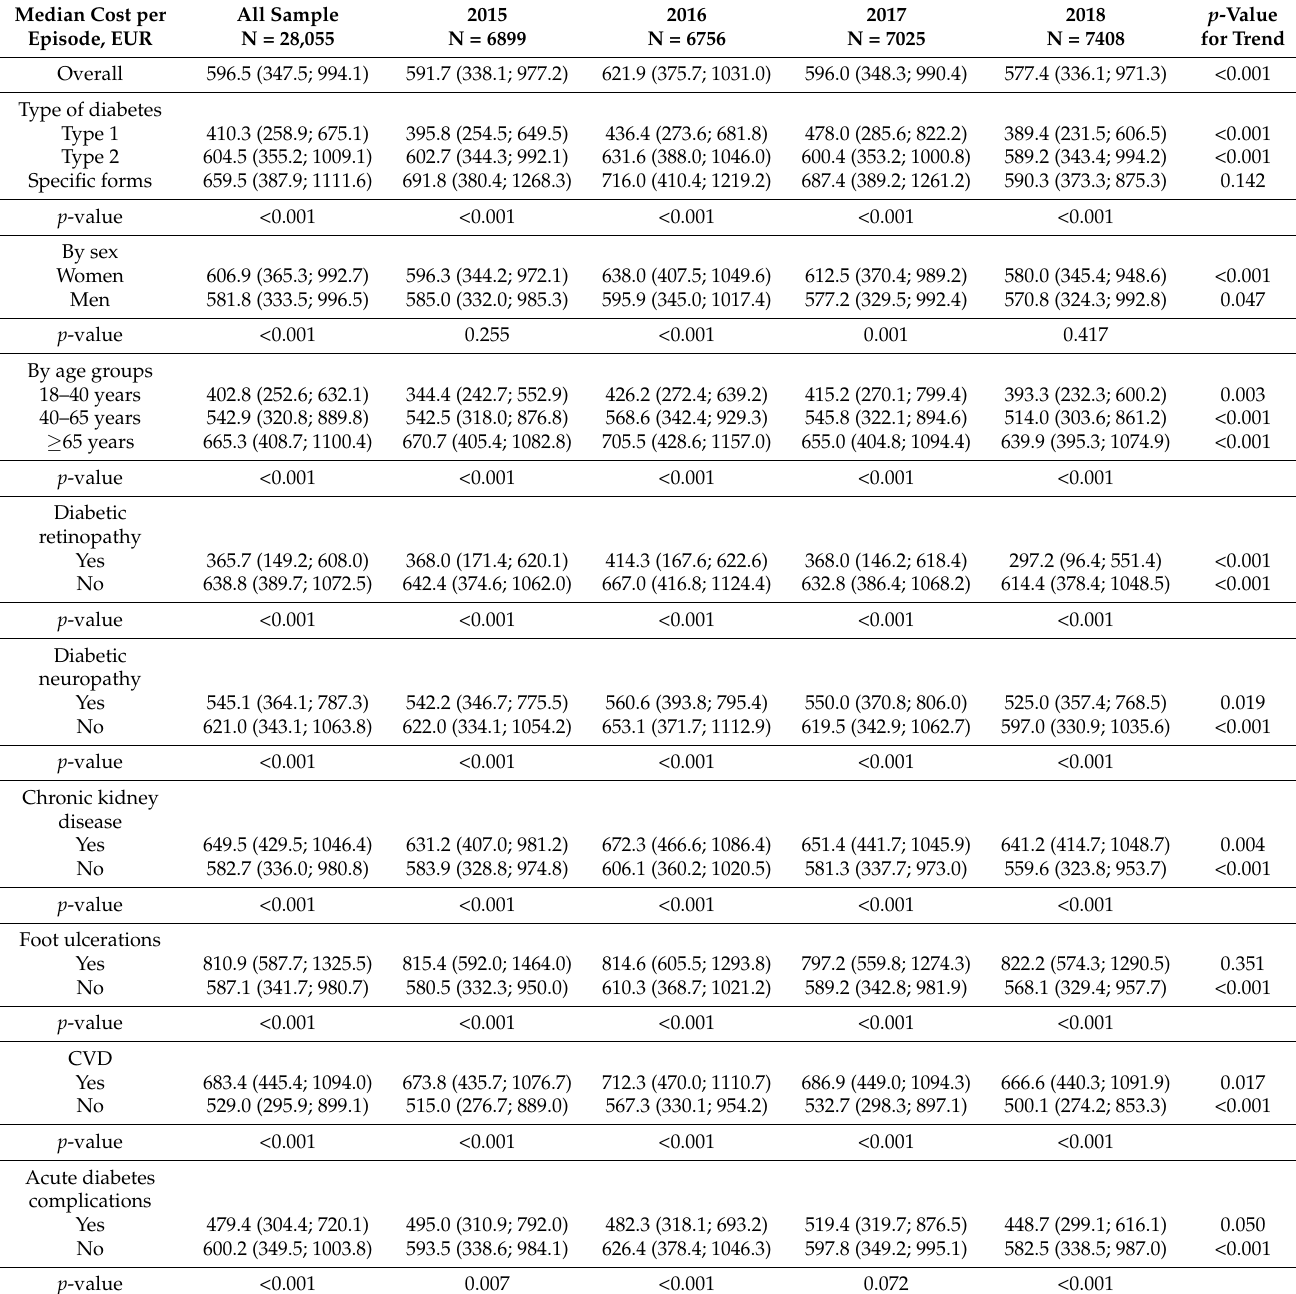
Table 3. Adjusted median cost (95% CI) per episode of hospitalization in the analyzed period